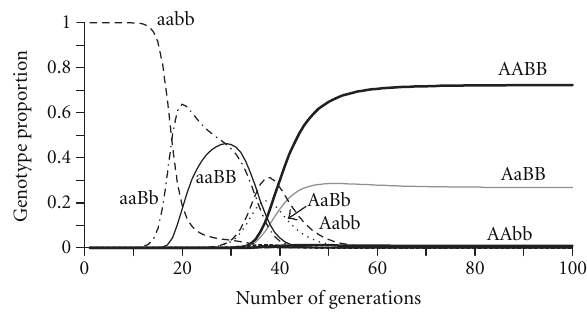
Figure 3: Change in proportions of the nine genotypes during 100 generations (example 3) with indiscriminate mating in which there were initially about 10 7 (0.9999998 aabb) individuals and initially one mutation of a to A (0.0000001 Aabb) and one of b to B (0.0000001 aaBb) resulting in 0.7230 AABB, 0.2681 AABb, and 0.09 AAbb (AABb never achieved any significant proportion). Relative survival of each genotype was S 1 = 0.9 (AABB), S 2 = 1 (AABb), S 3 = 0.4 (AAbb), S 4 = 0.7 (AaBB), S 5 = 0.8 (AaBb), S 6 = 0.3 (Aabb), S 7 = 0.4 (aaBB), S 8 = 0.5 (aaBb), and S 9 = 0.2 (aabb).